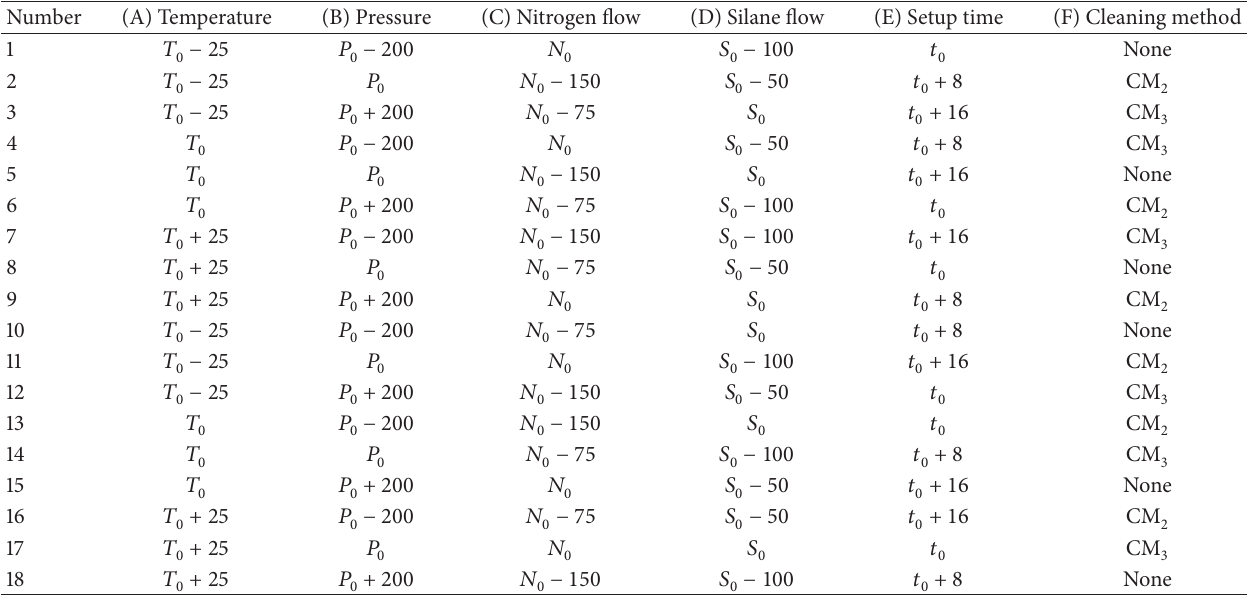
Table 1: 𝐿 18 ( 2 1 × 3 2 ) orthogonal table for control factors and levels.